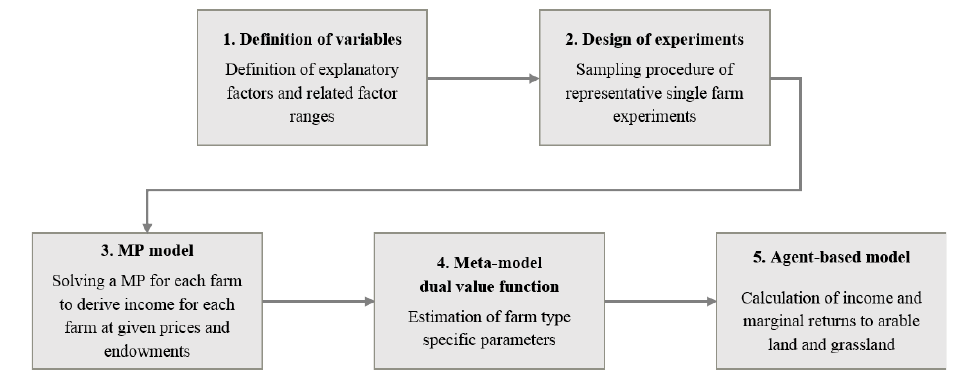
Figure 3. Steps in the meta-modeling